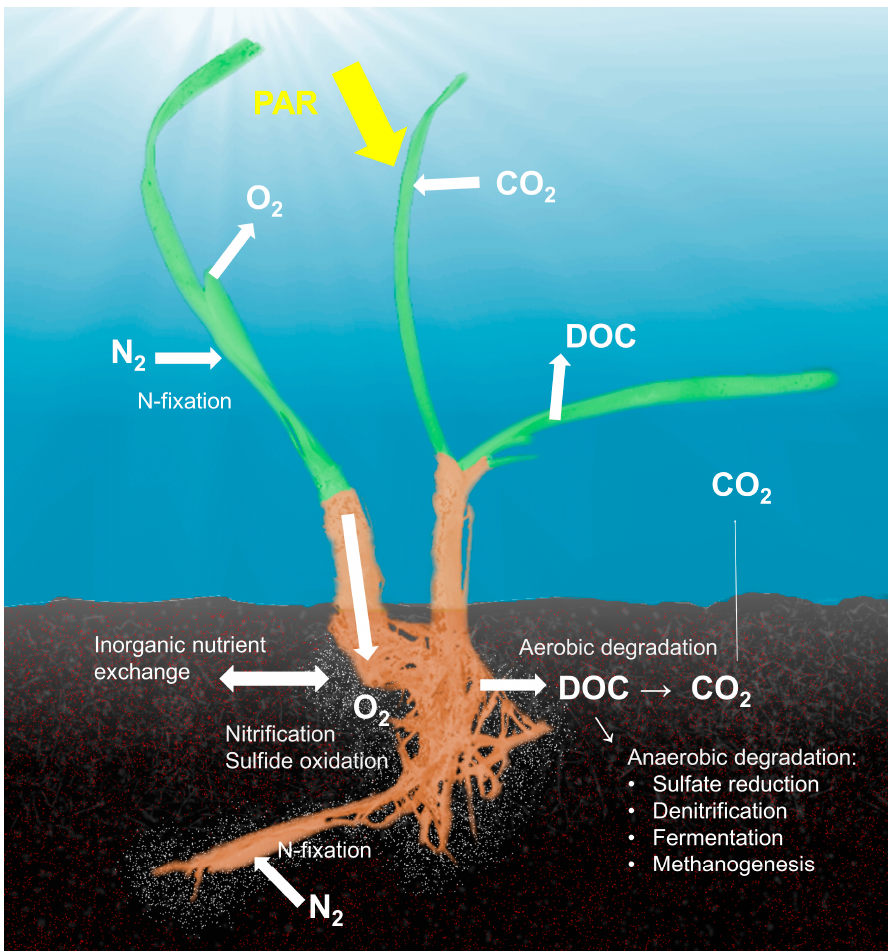
Figure 1. The most important interconnected processes within the seagrass holobiont are related